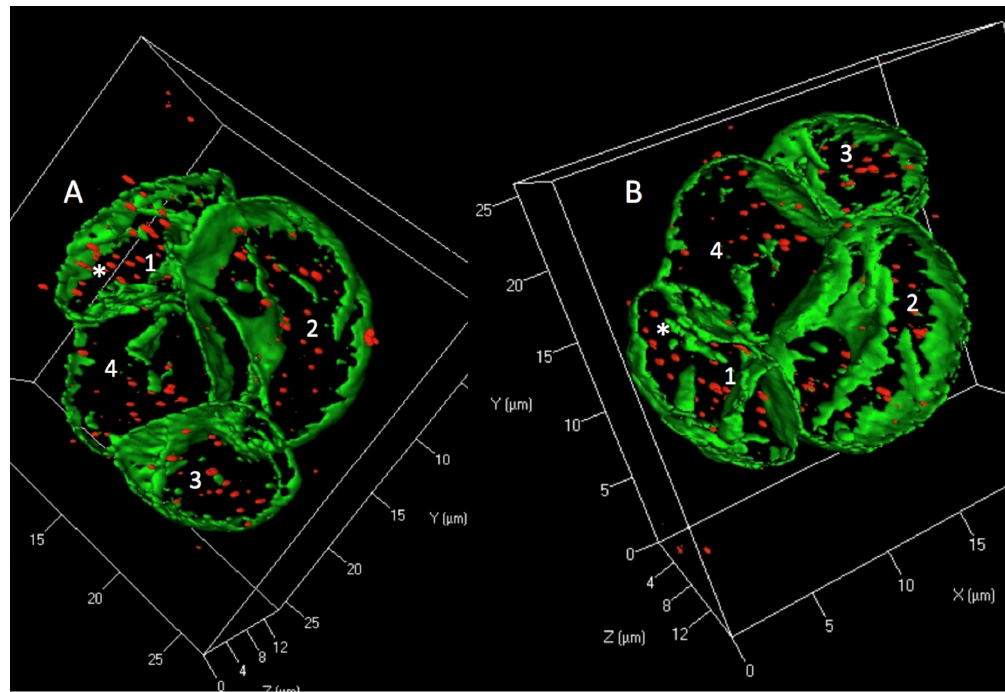
Figure 3. Tetra ‐ nuclear (nuclei 1–4) Reed–Sternberg cell of the Hodgkin cell line HDLM ‐ 2 is shown in Figure 3. Tetra-nuclear (nuclei 1–4) Reed–Sternberg cell of the Hodgkin cell line HDLM-2 is shown